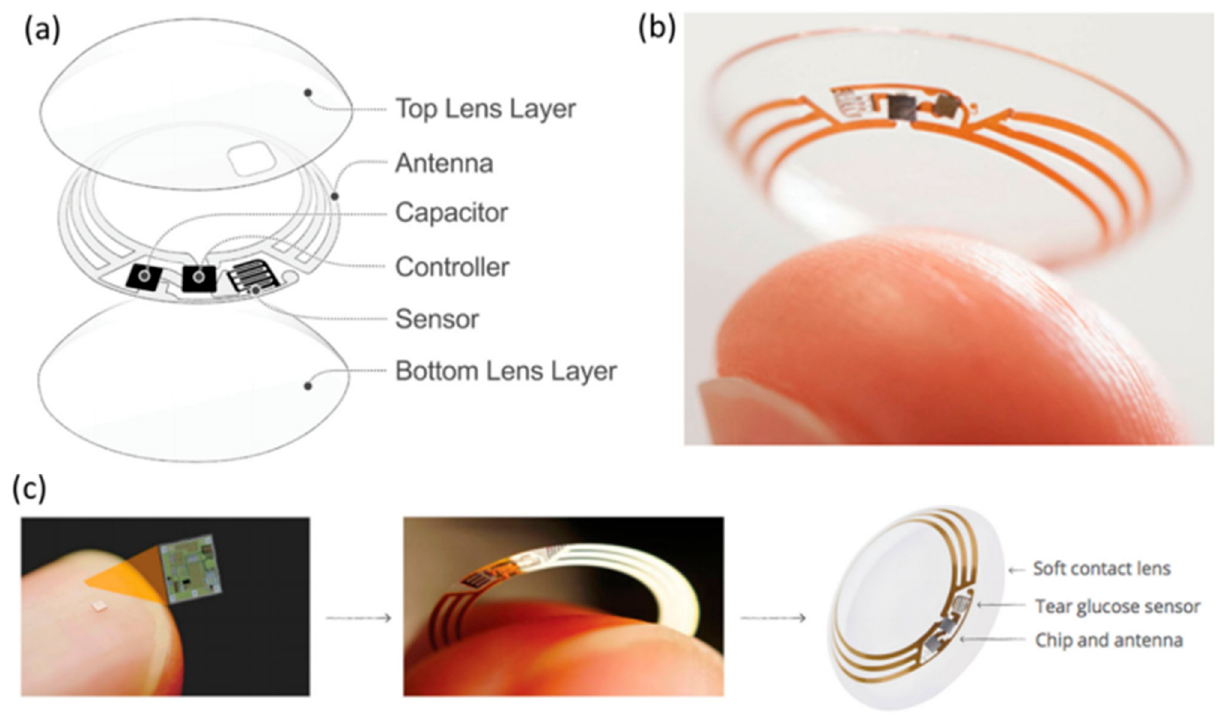
Figure 8. The contact lens sensor for tear glucose measurement, developed by Google and Novartis. ( a ) A diagram of the contact lens sensors. ( b ) The model contact lens sensor. ( c ) The wireless chip for the sensor. Reprinted with permission from reference [114]. Copyright 2021 John Wiley and Sons.